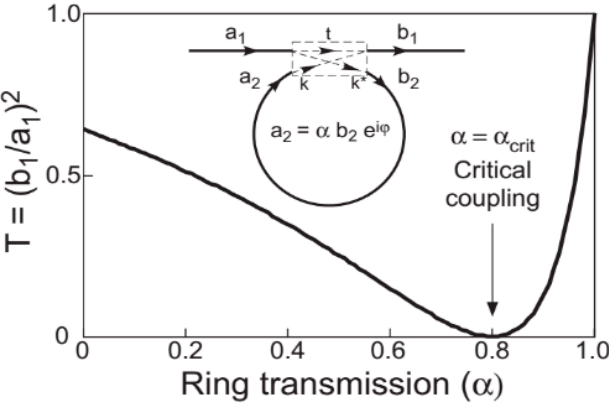
Figure 1. Transmission curve as a function of the ring transmission α for t = 0.8 at resonance. Inset: schematic diagram of the ring structure, with the definition of the straight waveguide and ring single pass transmission, t and α , respectively.